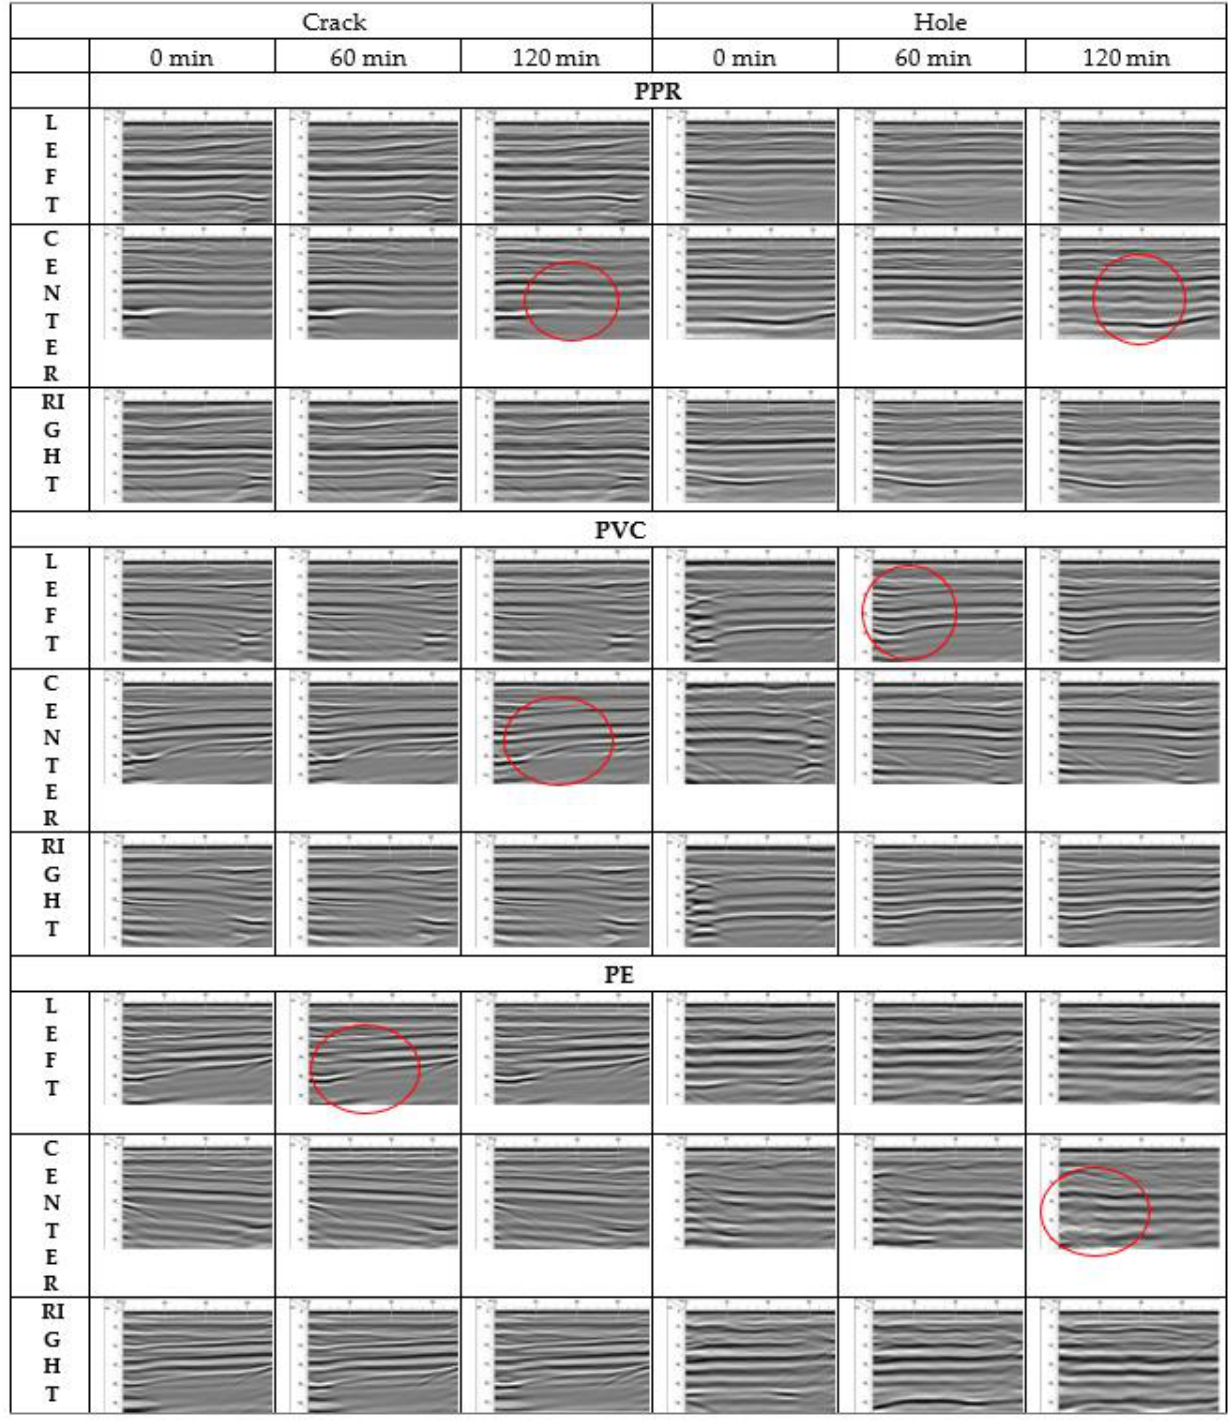
Figure 10. GPR images obtained on PPR, PVC and PE setup with 5% soil moisture content.